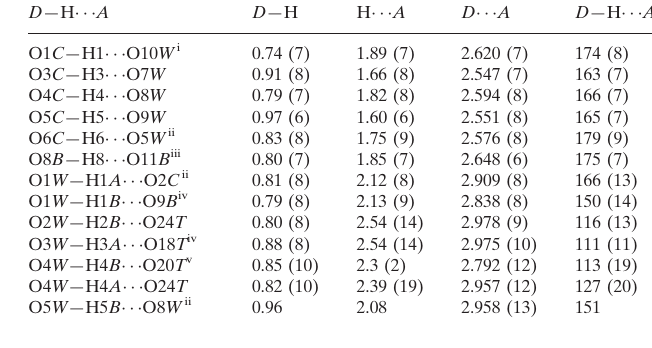
Hydrogen-bond geometry (A˚ , (cid:4)